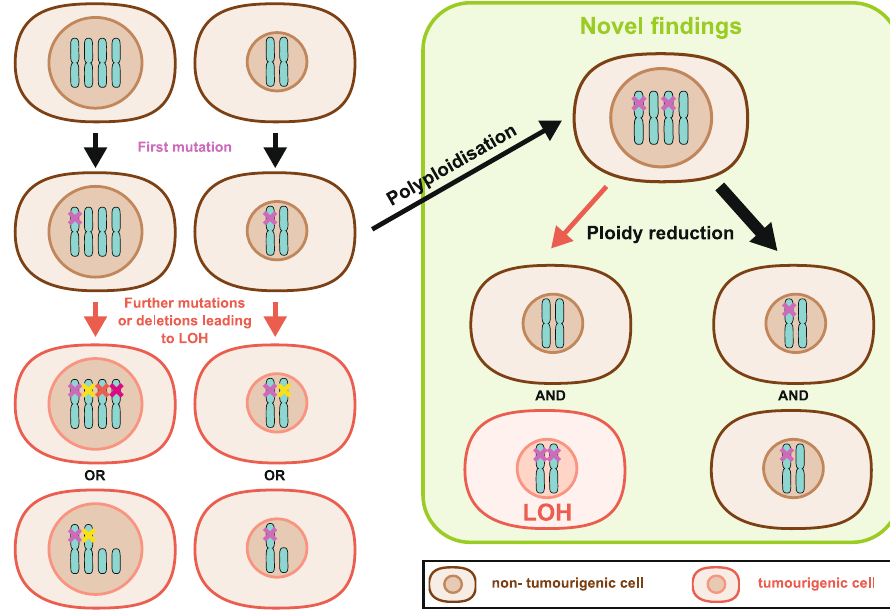
Fig. 1 Ploidy and loss of heterozygosity. Polyploid hepatocytes are believed to be protected from loss of heterozygosity (LOH) through the possession of multiple copies of each chromosome. The probability of independent mutations or deletions occurring across multiple copies of each chromosome is very rare compared to diploid cells. Loss of heterozygosity refers to the complete loss of function of a single tumour suppressor gene in all chromosomes either by mutation or deletion after prior mutation at a single locus. Complete loss of all functional copies of a tumour suppressor gene may impose dysregulated proliferation and tumourigenic potential. Matsumoto et al. 11 and Lin et al. 12 suggest that particularly for liver cancer dynamic changes in ploidy, fi rst polyploidisation then ploidy reduction of cells containing heterozygote loss of a tumour suppressor gene is associated with tumour initiation. Hypothetically mis-segregation of mutant tumour suppressor genes may occur during the process of ploidy reduction leading to LOH. Typically, while chromosomes are segregated faithfully (thick black arrow), which does not escalate the tumour risk, due to the proliferative advantage that LOH may impose even rare mis- segregation events can have a dramatic consequence and could lead to